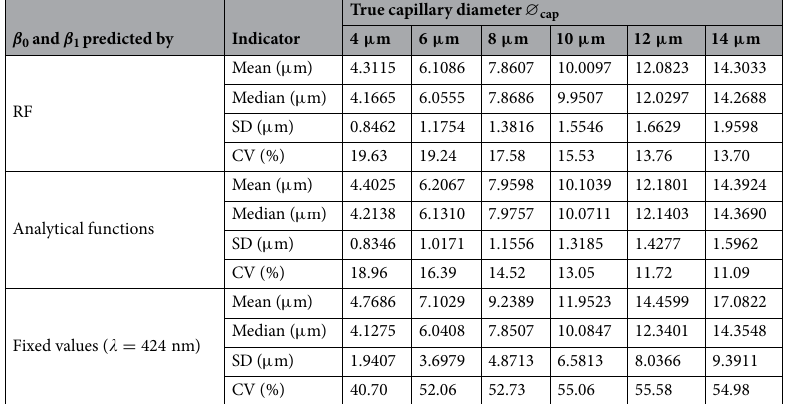
True capillary diameter ∅